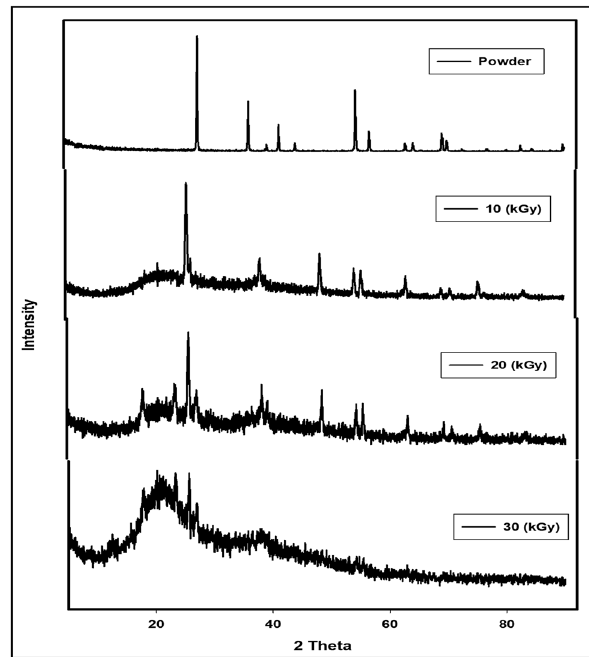
Figure 2: XRD curves of TiO 2 nanoparticles and irradiated CMC/starch/TiO 2 at 10, 20, and 30 kGy.